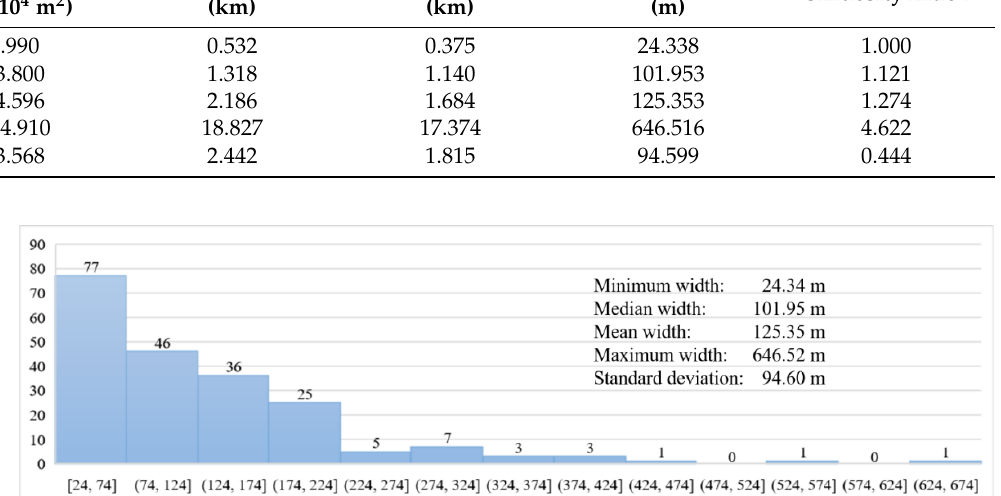
Figure 9. The width – abundance pattern of the river links in the Mobile – Tensaw River Delta. Figure 9. The width–abundance pattern of the river links in the Mobile–Tensaw River Delta.